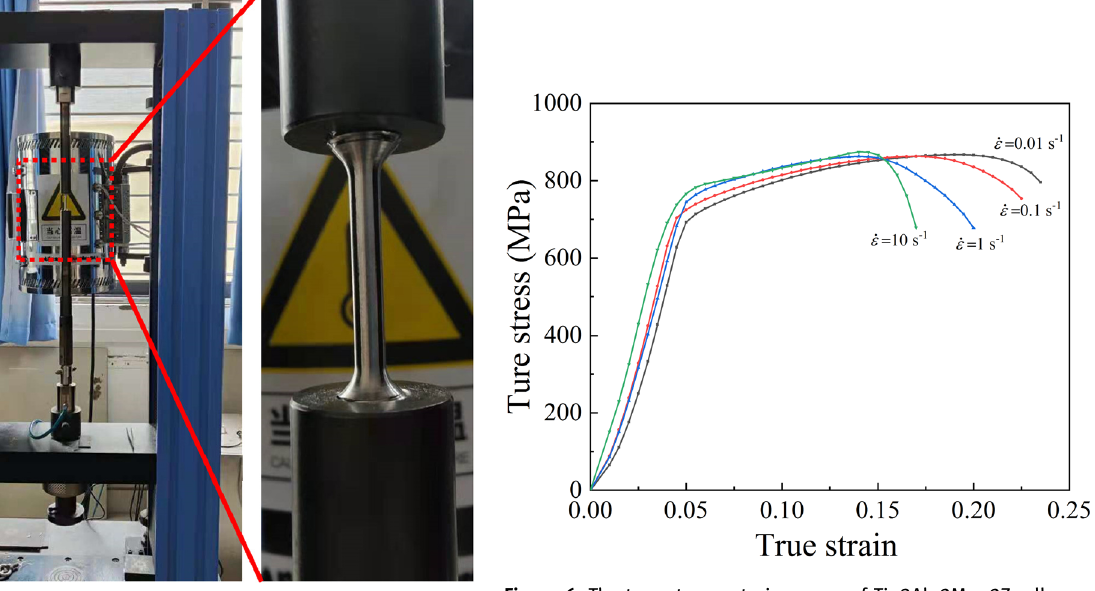
Figure 5: The setup of the uniaxial tensile experiments.